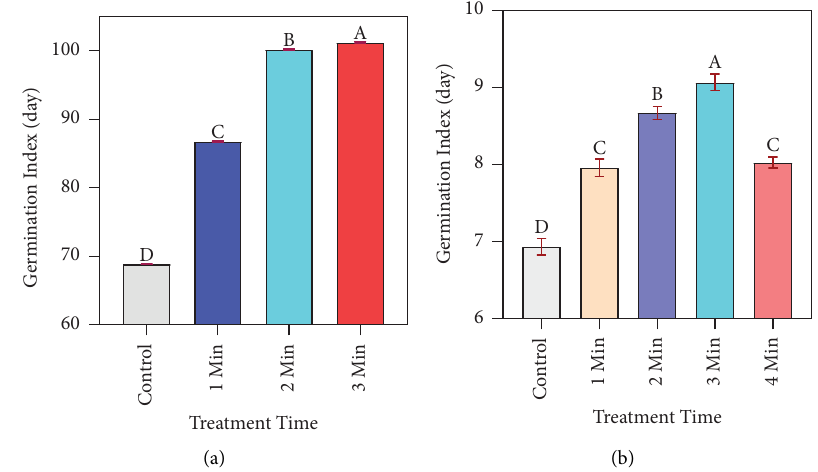
Figure 9: Efect of CAPP treatment on the GI of (a) radish and (b)